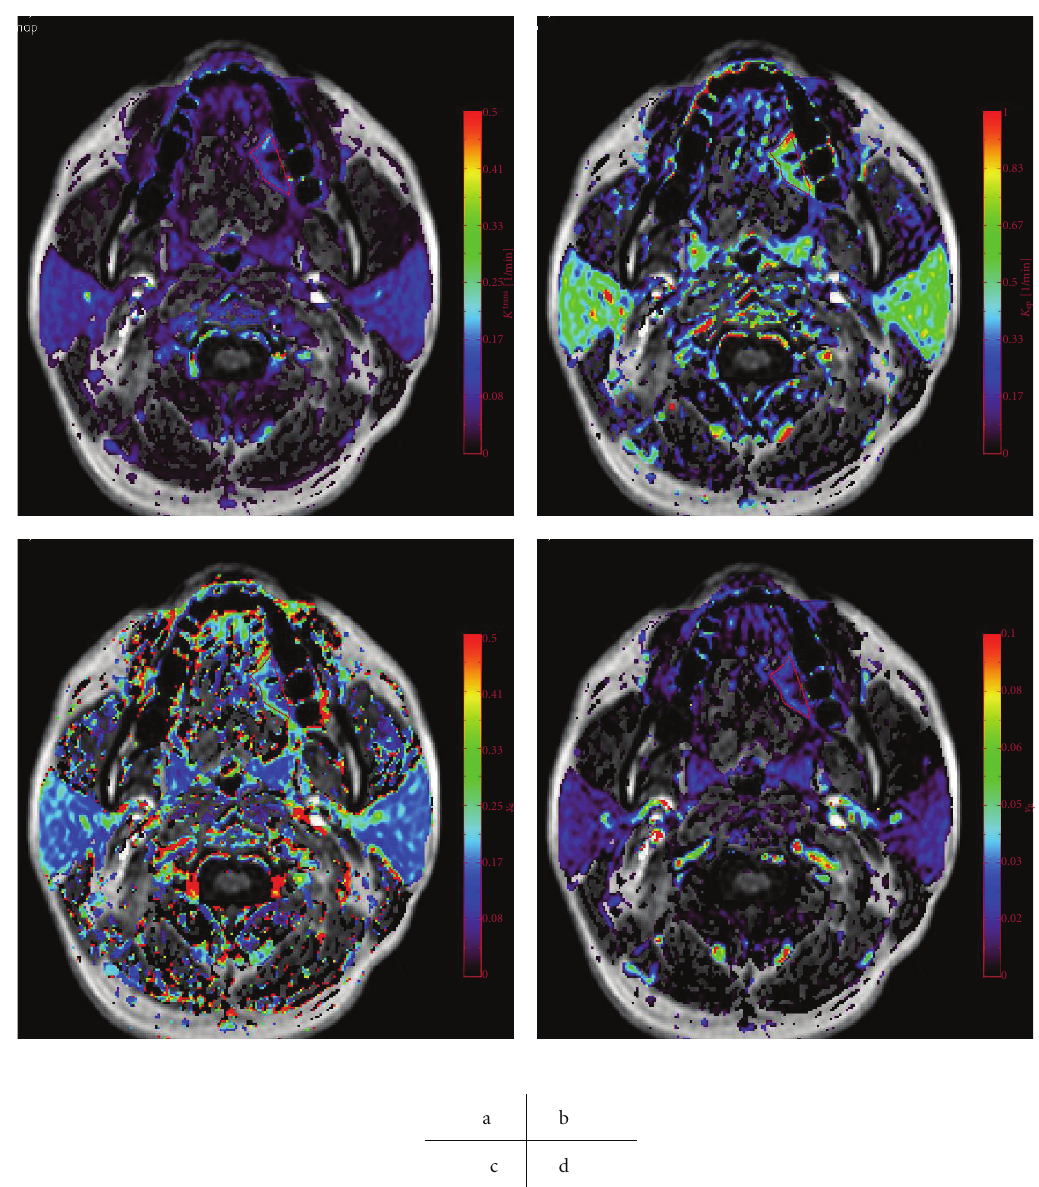
Figure 3: The parameter map of patients with left tongue cancer obtained by a TK model analysis. K trans (a), K ep (b), v e (c), and v p (d) map.